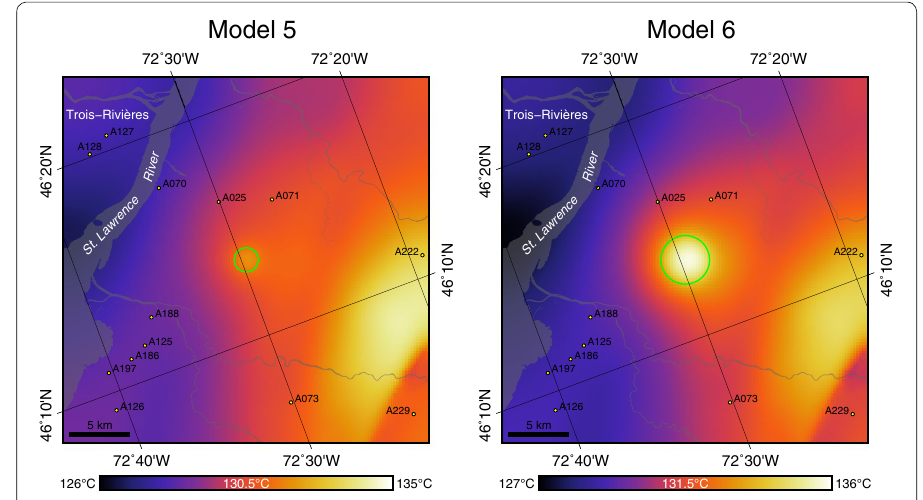
Fig. 9 Temperature distribution at 5 km for models with intrusions. Temperature distribution at 5 km for models with a 1 km radius vertical intrusion (left) and 2 km radius vertical intrusion (right) in the basement. Green circles are the surface projection of the vertical intrusion